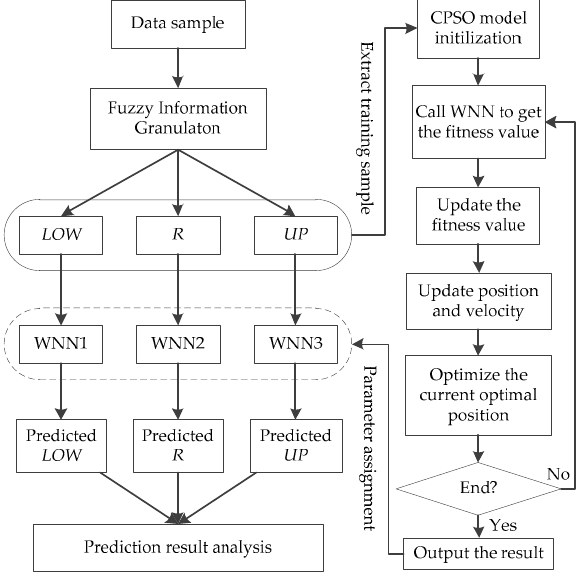
Figure 1. Flow chart of the new prediction model.